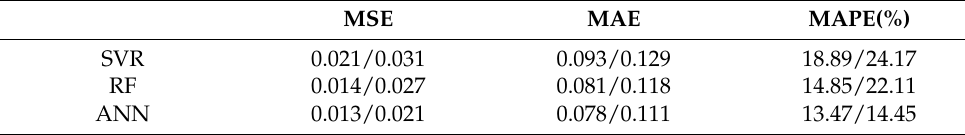
Table 2. Algorithm performance evaluation (Guangzhou terminal area/Wuhan terminal area).